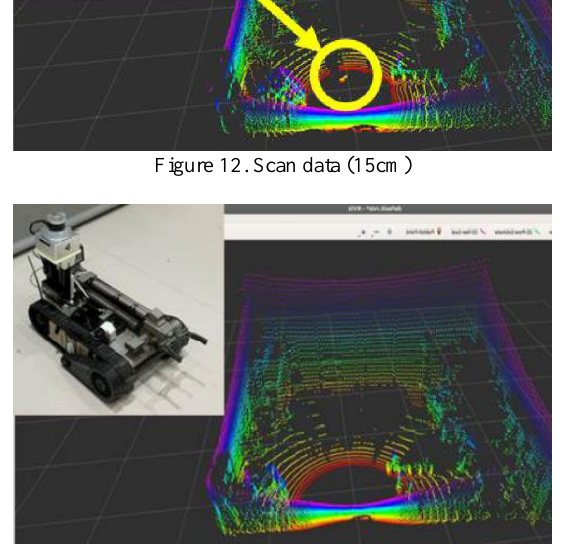
Figure 13. Scan data (30cm)